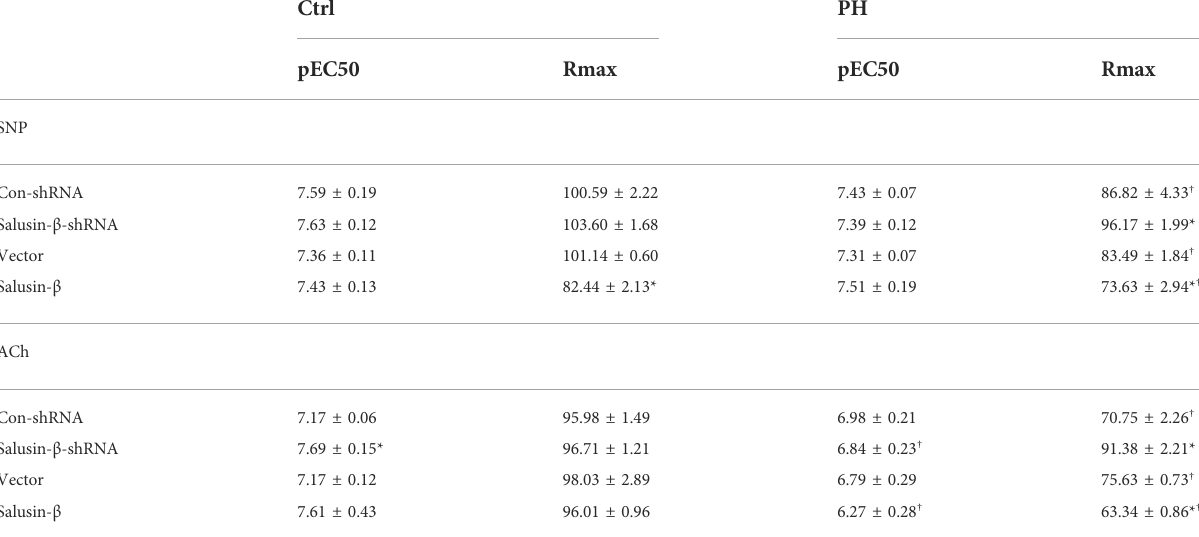
TABLE 2 pEC50 and Rmax (%) data of SNP or ACh-induced dose-dependent vasodilatation of PAs in Ctrl and PH rats with different